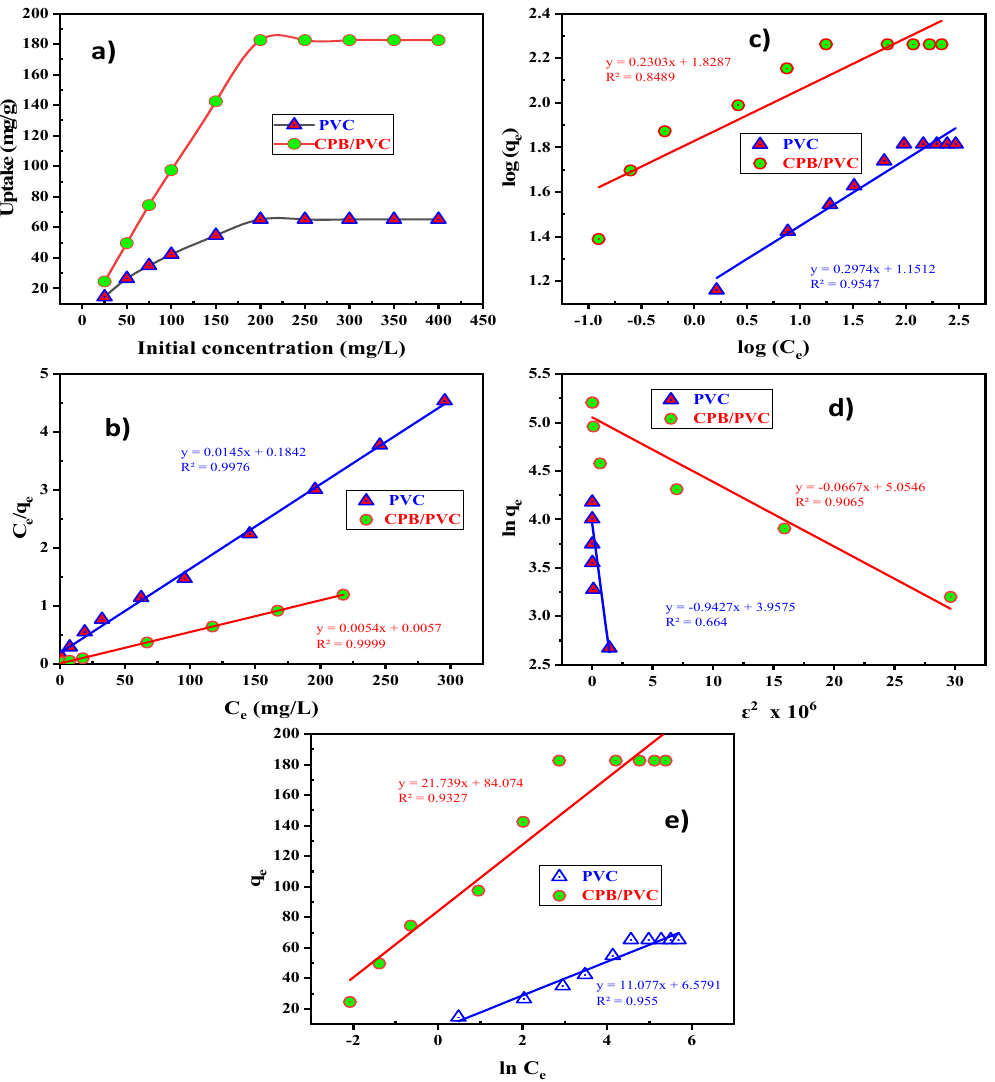
Figure 8. ( a ) Effect of initial REE concentration on REE uptake, ( b ) Langmuir, ( c ) Freundlich, ( d ) Dubinin and Radushkevich, and ( e ) Temkin isotherm models of REE sorption on PVC and CPB/PVC.